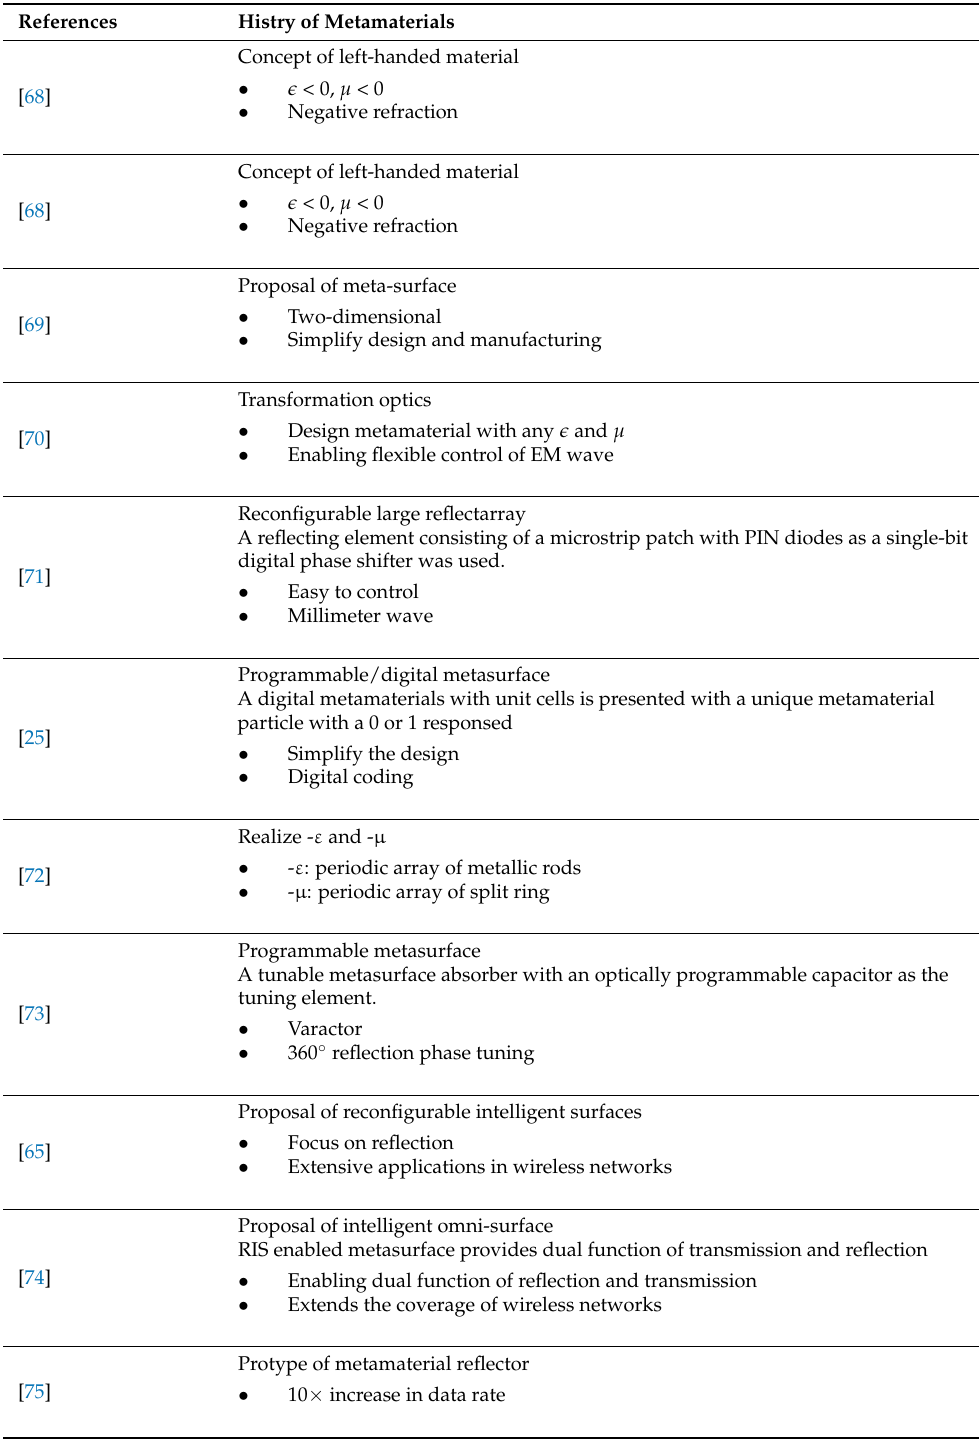
Table 4. State of the art schemes for